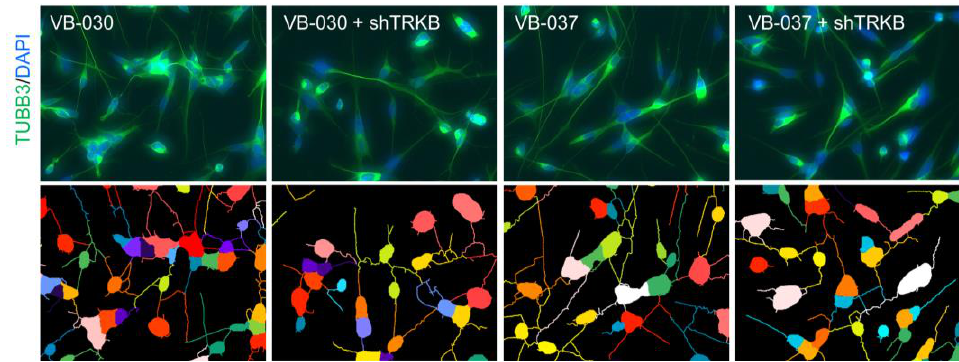
Figure 6. TRKB RNA interference of ∆K280 Tau RD -DsRed SH-SY5Y cells. ( A ) Experimental flow chart. On day 1, ΔK280 Tau RD -DsRed SH-SY5Y cells were plated in the presence of retinoic acid (RA; 10 µM). The cells were infected with lentivirus-expressing TRKB-specific or scrambled shRNA at day-2. At 24 h post-infection, LM-031, ZN-015, VB-030 or VB-037 (10 µM) was added for 8 h, followed by induction of Tau RD -DsRed expression (Dox, 2 µg/mL) for 6 days. The cells were collected for TRKB and neurite outgrowth analyses at day 9. ( B ) Protein level of TRKB in compound-treated cells infected with TRKB-specific or scrambled shRNA-expressing lentivirus ( n = 3). GAPDH was used as a loading control. The relative TRKB of uninduced cells was normalized to 100%. ( C ) High-content assessment of neurite outgrowth (TUBB3 stain, green) ( n = 3). The length, process and branch of neurite was calculated. Nuclei were counterstained with DAPI (blue). Shown below are the multi-color segmented fluorescence images to assign the outgrowth of a cell body for quantification. Different colors outline different neurons and their respective neurite outgrowth. The arrows indicated in uninduced photo are process (red) and branch (white). p values: comparisons between induced vs. uninduced cells ( ## : p < 0.01, ### : p < 0.001), compound-treated vs. untreated (induced) (**: p < 0.01, ***: p < 0.001), or TRKB shRNA-treated vs. scrambled shRNA-treated cells ( & : p < 0.05, && : p < 0.01, &&& : p < 0.001) (one-way ANOVA with a post hoc Tukey test).